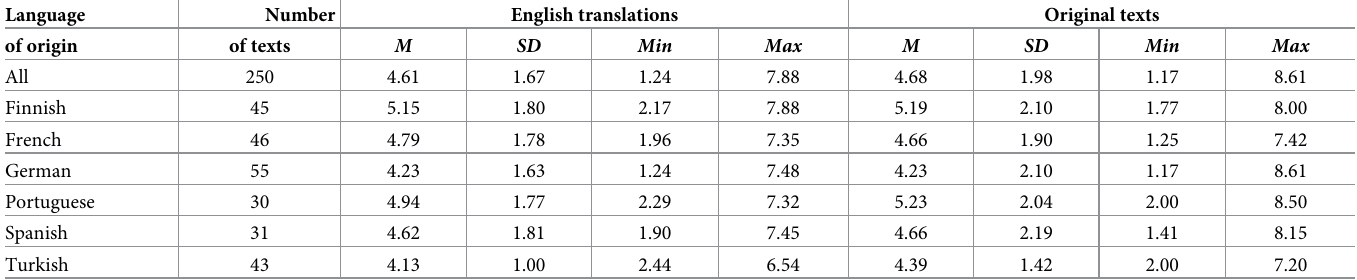
Table 2. Means, standard deviations, and minimum and maximum values of valence for all texts, separately for the English translations and the original language versions. Language